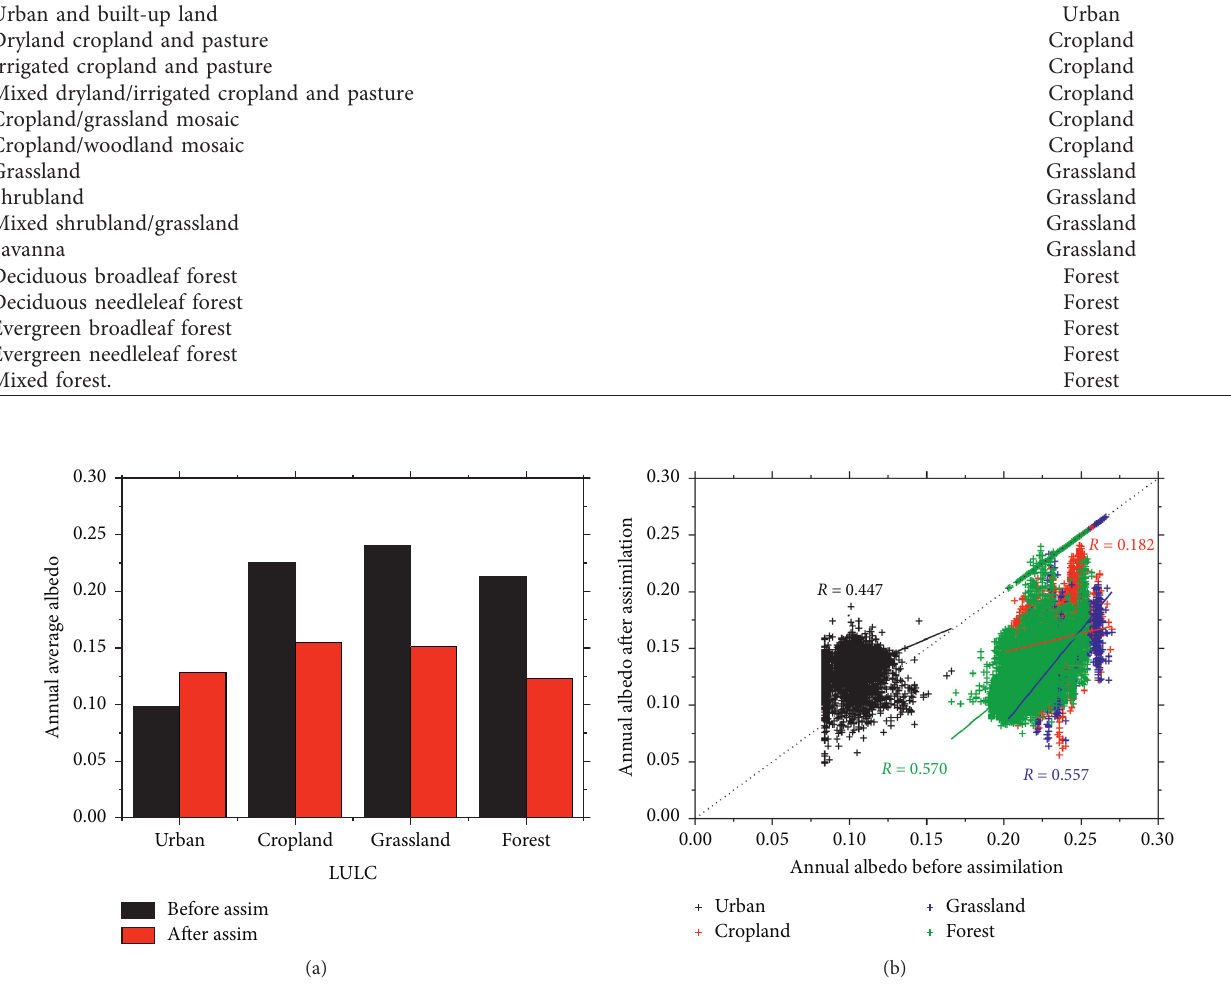
Figure 6: (a) Spatial average of the annual average albedo simulations before and after assimilation for the four main LUCs; (b) scatter plot of the annual average albedo simulations before and after assimilation for the four main LUCs.